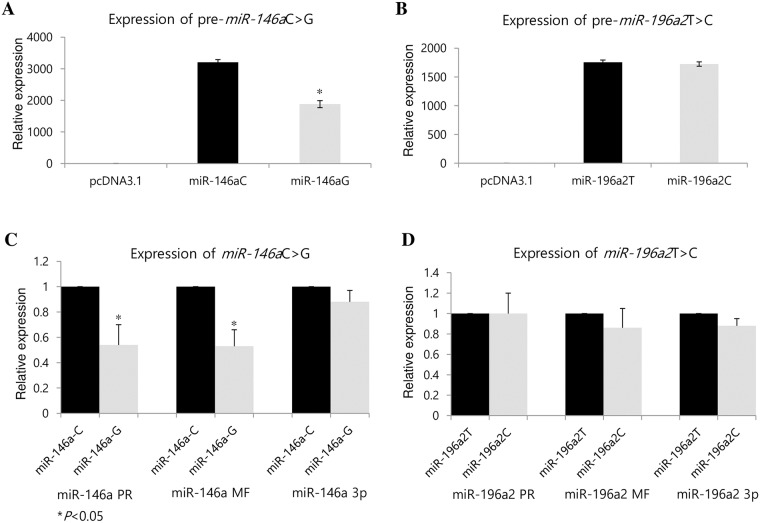
Expression of miR-146aC>G and miR-196a2T>C.(A) Levels of mature miR-146a and (B) Levels of mature miR-196a2 in cells transfected with pri-miR-146a-GG, pri-miR-146a-CC or pri-miR-196a2TT, pri-miR-196a2CC by reverse transcription quantitative polymerase chain reaction. (C) Real-time quantitative PCR was used to detect the expression levels of pre, mature, and mature-3p in miR-146aC>G (rs2910164) and (D) miR-196a2T>C (rs11614913). Data are reported as means (±SD) from three independent experiments. Data are normalized to the reference RNU6. P<0.05 was considered statistically significant. PR: Pre-form, Mature: mature form, -3p: mature form of passenger strand.